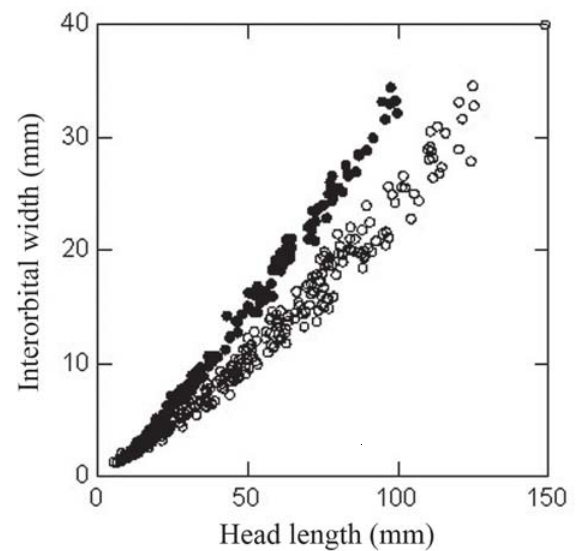
Fig. 7. Interorbital width vs . head length for Hoplias curupira (dots) and remaining species of Hoplias lacerdae group (circles). profile of head almost straight. Dorsal margin of orbit reaching dorsal profile of head in specimens smaller than 85 mm SL, but falling short of dorsal profile of head in larger specimens ( e . g ., 160 mm SL). Head relatively broad, especially dorsally (Figs. 6-7). Dorsal profile of body convex from vertical through first series of scale of body to dorsal-fin origin; straight and posteroventrally inclined along dorsal-fin base; concave from vertical through base of last dorsal-fin ray to origin of dorsal most procurrent caudal-fin ray. Latter portion of profile slightly less concave in specimens smaller than 85 mm SL. Caudal peduncle robust, relatively deep. Ventral profile of lower jaw